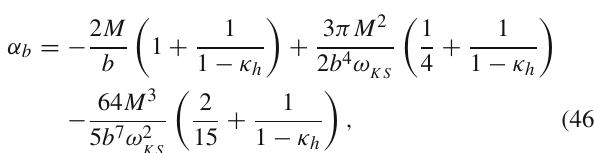
Fig. 4 Homogeneous case: In the first two rows, we show the depen- dence of the deflection angle of photon with dimensionless impact parameter ( b / M ) for various combinations of dimensionless “Hoˇrava” parameter( ˜ ω )andplasmaparameter.Inthethirdrow,thedependence KS